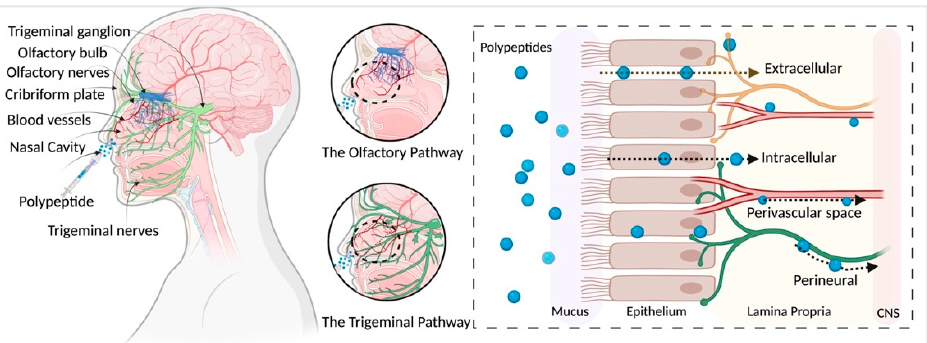
Figure 1. Pathways of polypeptide distribution after IN administration. Olfactory and trigeminal pathways are major contributors to intranasal delivery of polypeptides to the nervous system. Compounds pass through the nasal epithelium to reach the lamina propria largely via extracellular transport and reach the CNS mainly via bulk flow through the perineural, perivascular spaces. Created with BioRender.com (accessed on 21 May